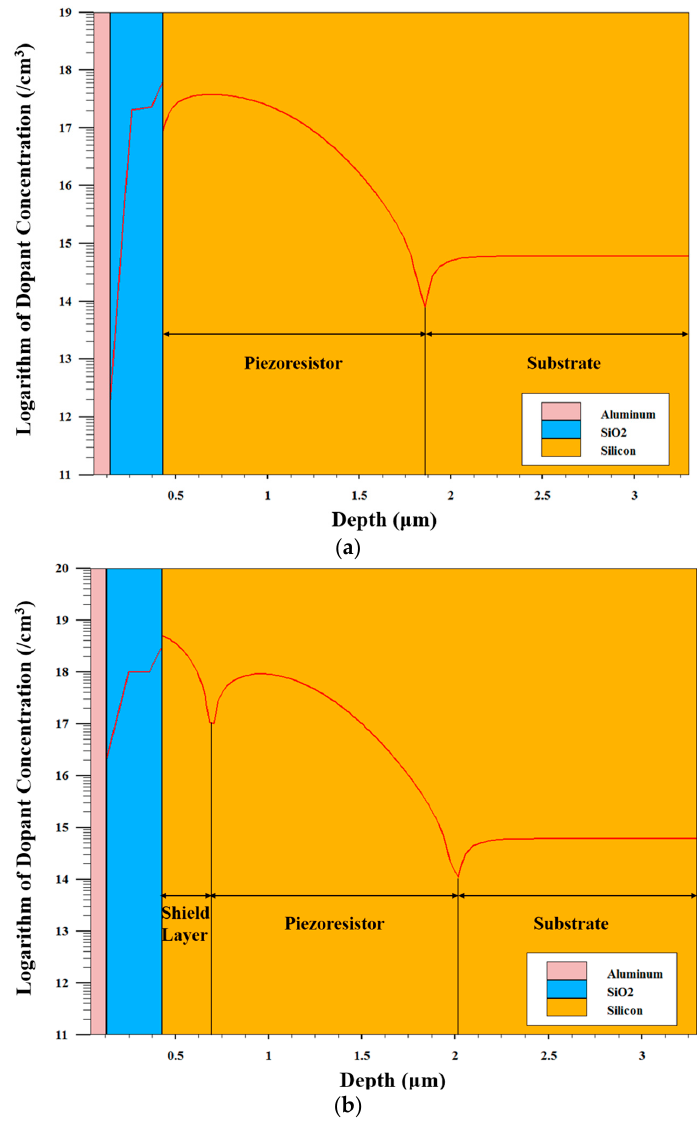
Figure 6. Dopant concentration versus depth without ( a ) and with ( b ) a shield layer.